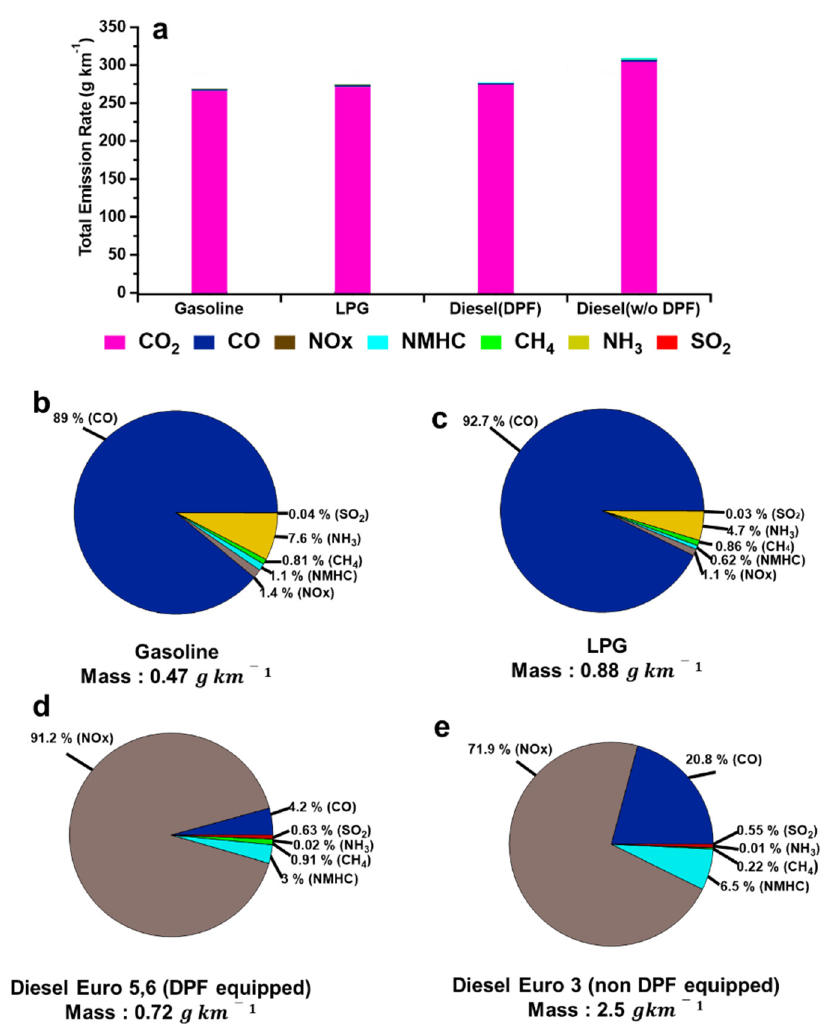
Figure 3. ( a ) Rates of CO 2 emission of gases constituting different fuels. Mass fractions all gases except CO 2 in ( b ) gasoline, ( c ) liquefied petroleum gas (LPG), ( d ) diesel particulate filter (DPF)-equipped diesel, and ( e ) non-DPF-equipped diesel. All values correspond to total averages calculated during